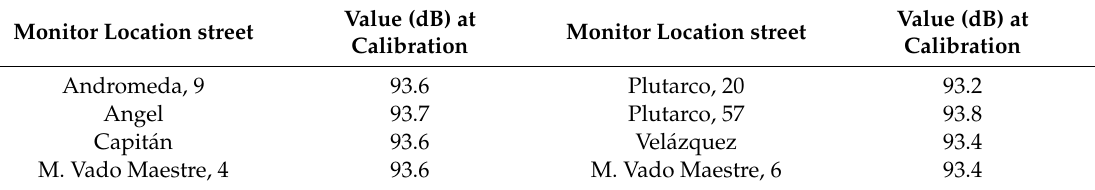
Table 6. Verification values after installation outdoors (94 dB